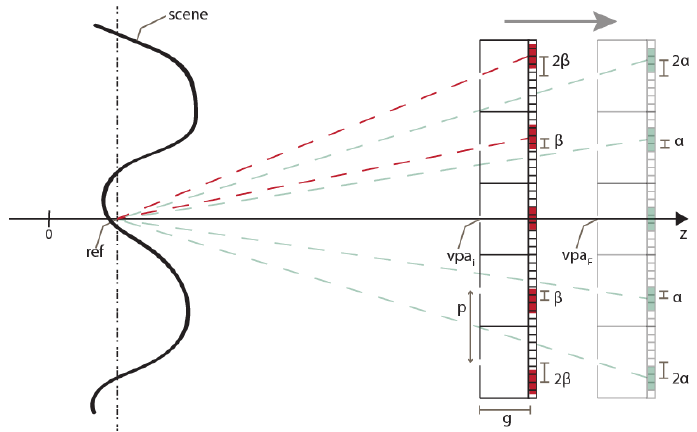
Figure 4. The procedure to set the reference plane’s position. Note that, for graphical convenience, a VPA with pitch equal to the dimension of a single pinhole camera is shown. Actually, the pitch is smaller, so the virtual pinhole cameras overlap with each